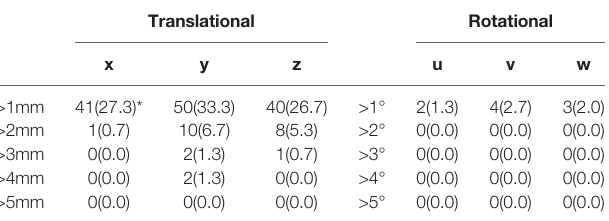
TABLE 2 | Frequency of deviation [%] between PE-B1 and PE-B2 by thresholds. Translational Rotational